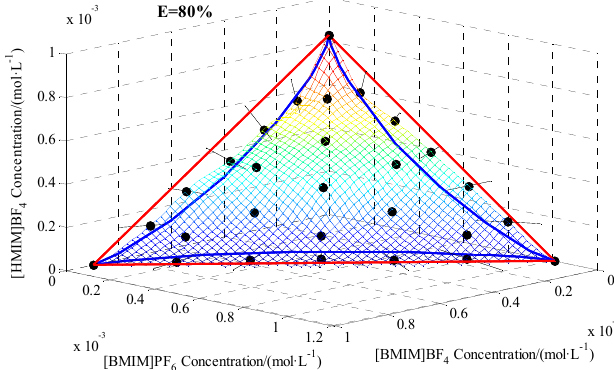
Figure 4. Equivalent-surface of ILs mixtures at 20%, 50%, and 80% effect levels. Note: Black point: observed point; Black line: confidence interval of observed point; Grid: observed equivalent-surface (ES); Red: CA ES; Blue: IA ES.